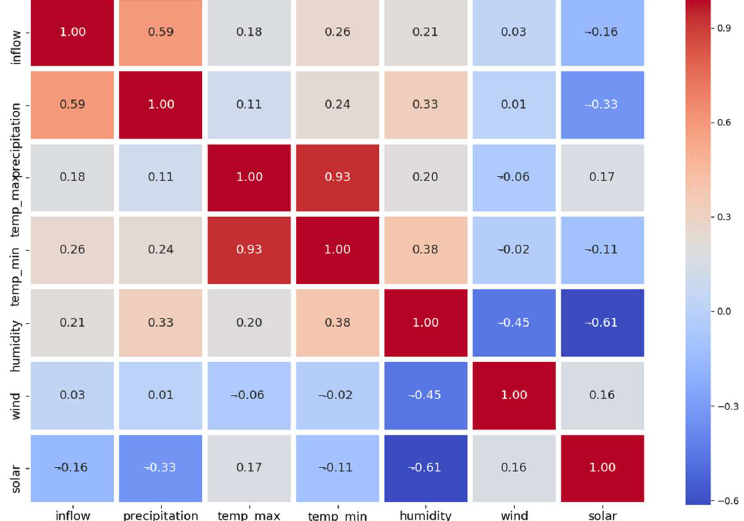
Figure 5. Heat map to analyze correlation coe ffi cients of model input data in Soyang River Dam.